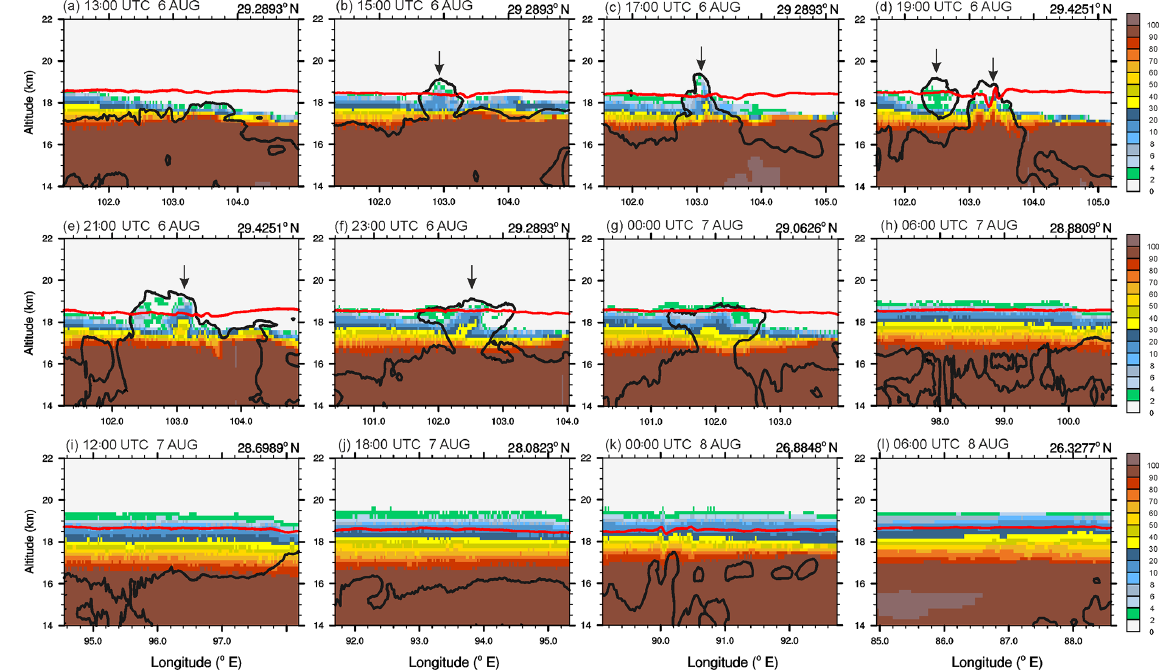
Figure 8. Same as Fig. 6 but for the tracer (%). The isentropic altitude of 410K is depicted by the red line. The changes of the tropospheric tracer by convective overshoots is marked by downward